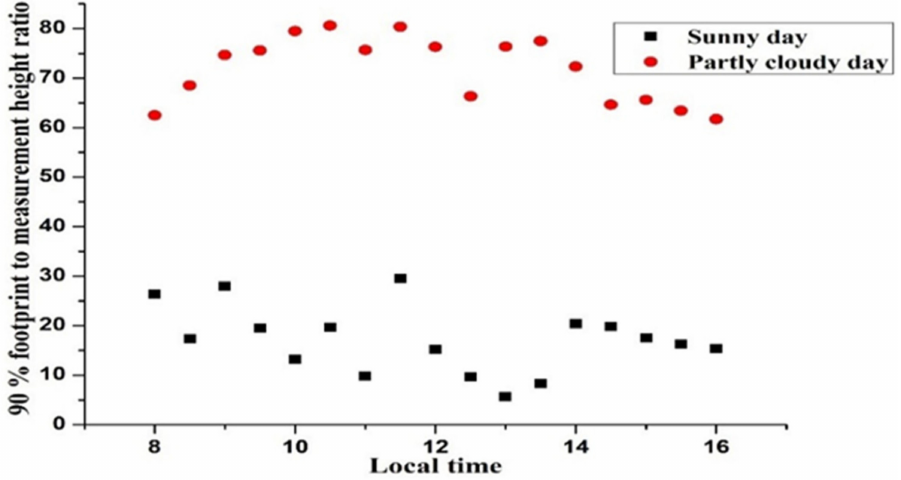
Figure 11. Variation in half-hourly 90% footprint to measurement height ratio for two days, one cloudy day (1 June 2019) and the other cloudy to sunny day (23 March